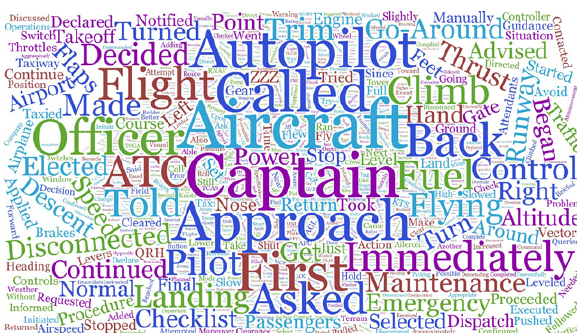
Figure 4. Word cloud of narrative elements coded as action